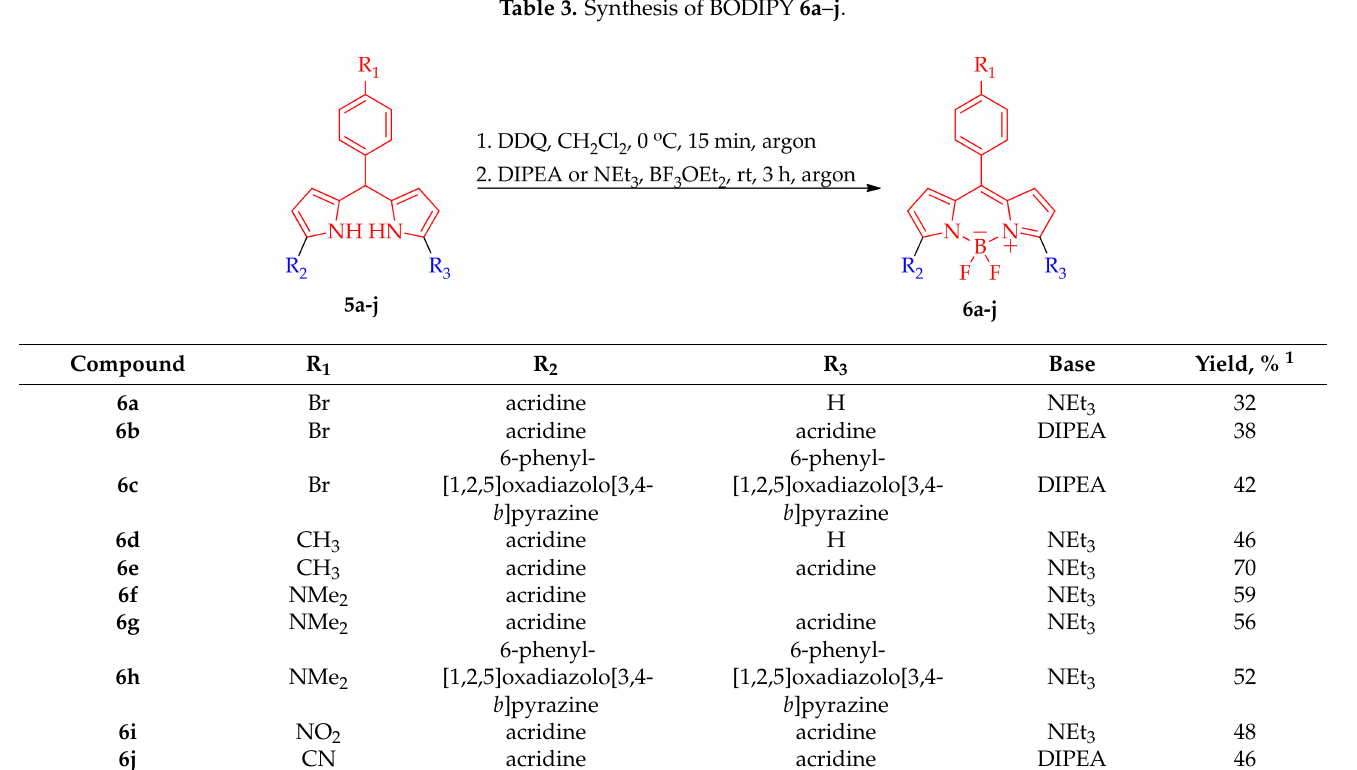
Table 3. Synthesis of BODIPY 6a – j